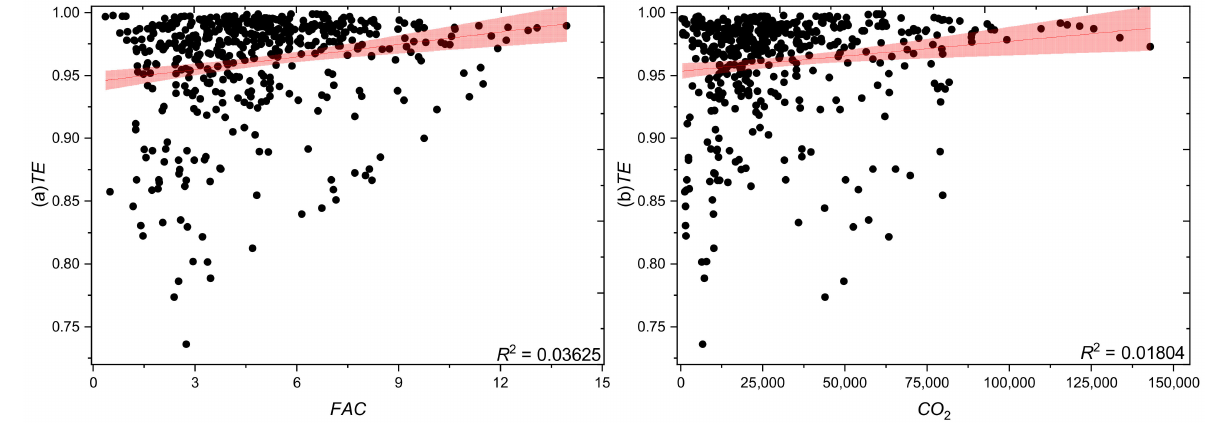
Figure 3. Changes in factor market distortions, carbon dioxide emissions and TE scatter